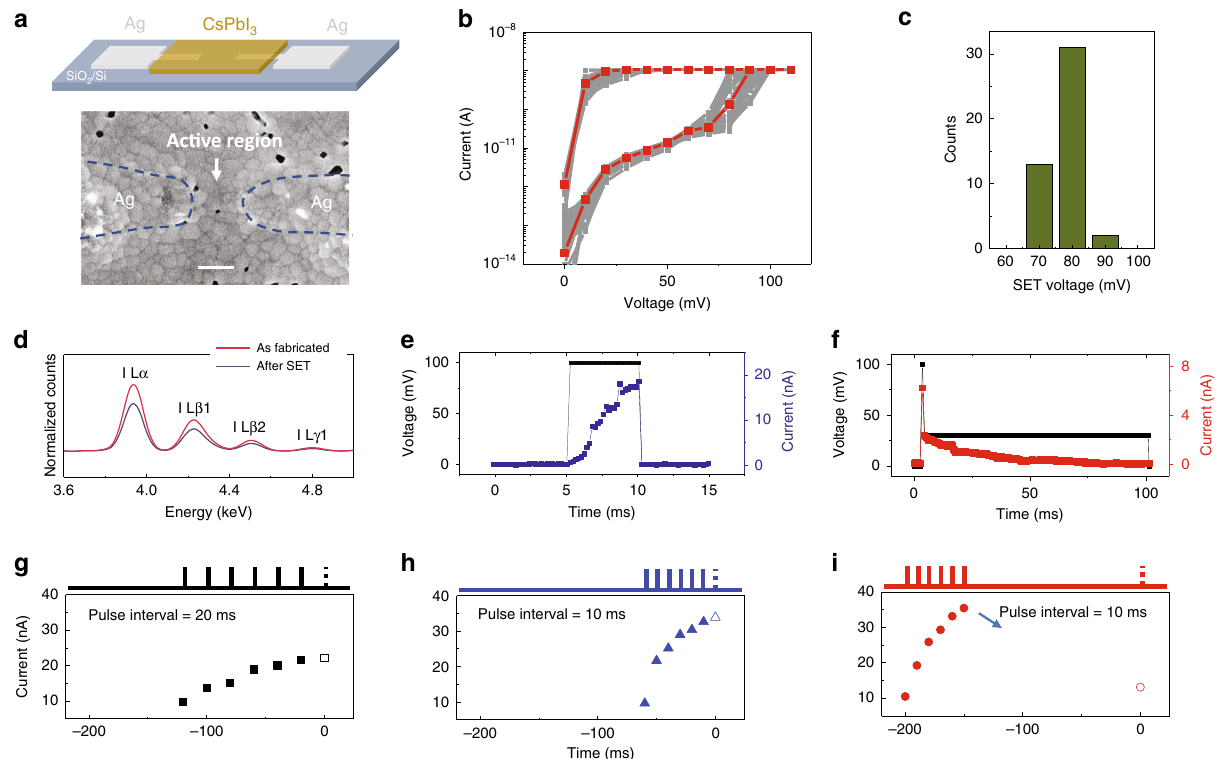
Fig. 2 CsPbI 3 -based memristor with low programming voltage and short-term memory effect. a Schematic (upper) and SEM image (bottom) of an as- fabricated Ag/CsPbI 3 /Ag memristor device. Scale bar: 200 nm. b Current – voltage ( I – V ) characteristics of the device during 46 SET processes. A typical I – V curve is highlighted in red. c Histogram of the SET voltage extracted from b . d EDX spectra of a device showing characteristic Iodine X-ray peaks (L series) before (red curve) and after (blue curve) the SET process. The intensity of the Iodine X-ray peaks is reduced after SET process. e Evolution of the device current (blue curve) with time during the application of a stimulation pulse (black curve, 100 mV, 5 ms, started at t = 5 ms). f Evolution of the device current (red curve) with time during the application of a stimulation pulse (100 mV, 2 ms, started at t = 3 ms) followed by a long read pulse (30 mV, 100 ms, black curve). g – i Current responses in a Ag/CsPbI 3 /Ag device subjected to seven identical stimulation pulses (100 mV, 2 ms) with different pulse interval conditions. The device currents recorded at t = 0 ms are represented as open